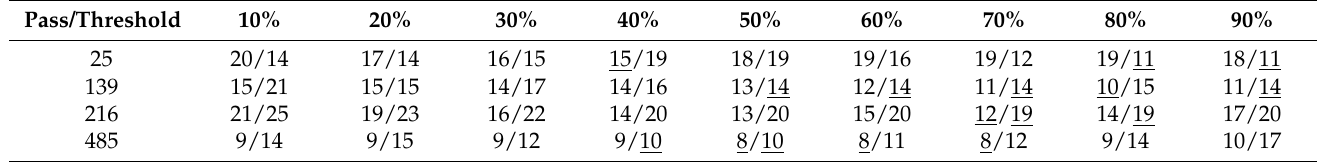
Table 5. Waveform statistical information.